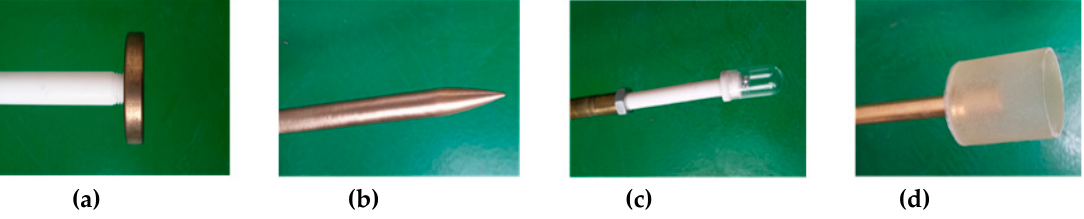
Figure 12. Artificial defect models used in our tests: ( a ) Floating discharge model; ( b ) Protrusion discharge model; ( c ) Particle discharge model; ( d ) Air-gap discharge model.